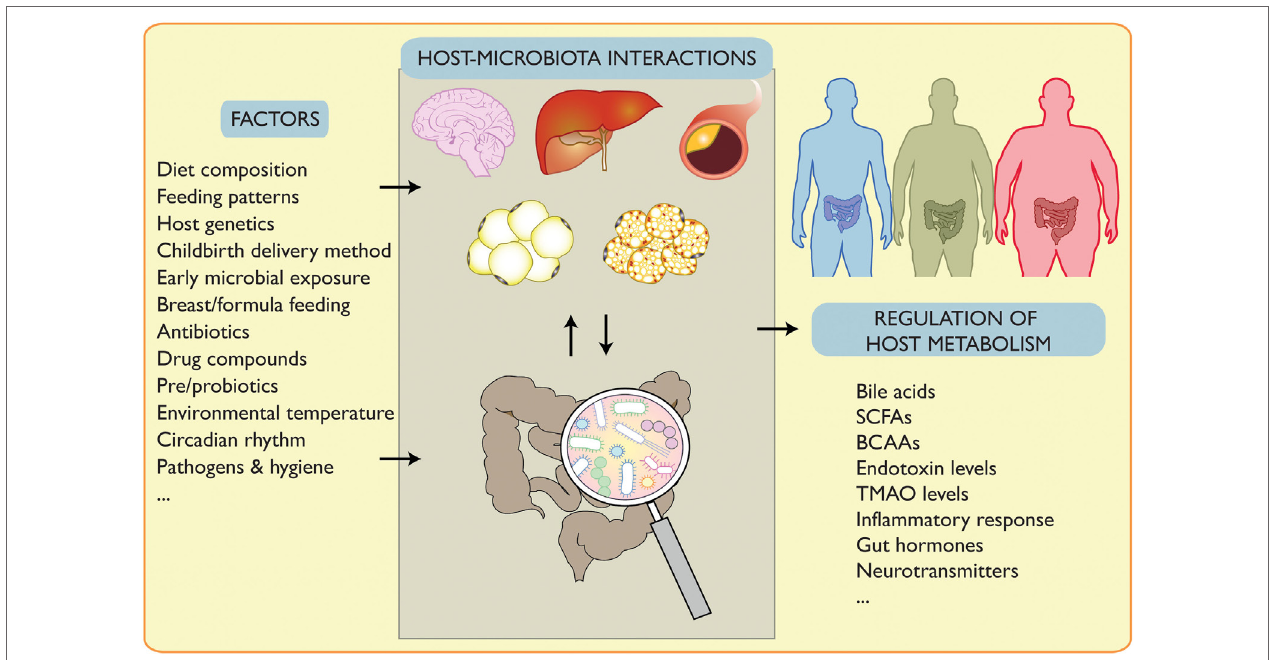
FiGURe 1 | Signals affecting host–microbiota interplay and its regulation of metabolism. Gut microbiota composition is affected by endogenous and exogenous factors such as lifestyle interventions. Changes in the microbiota affect its interplay with several organs and can regulate pathophysiological conditions. This can be mediated by altered bile acids, short chain fatty acids (SCFAs), branched-chain amino acids (BCAAs), endotoxin, trimethylamine N -oxide (TMAO), inflammation, gut hormones and neurotransmitters, and potentially other